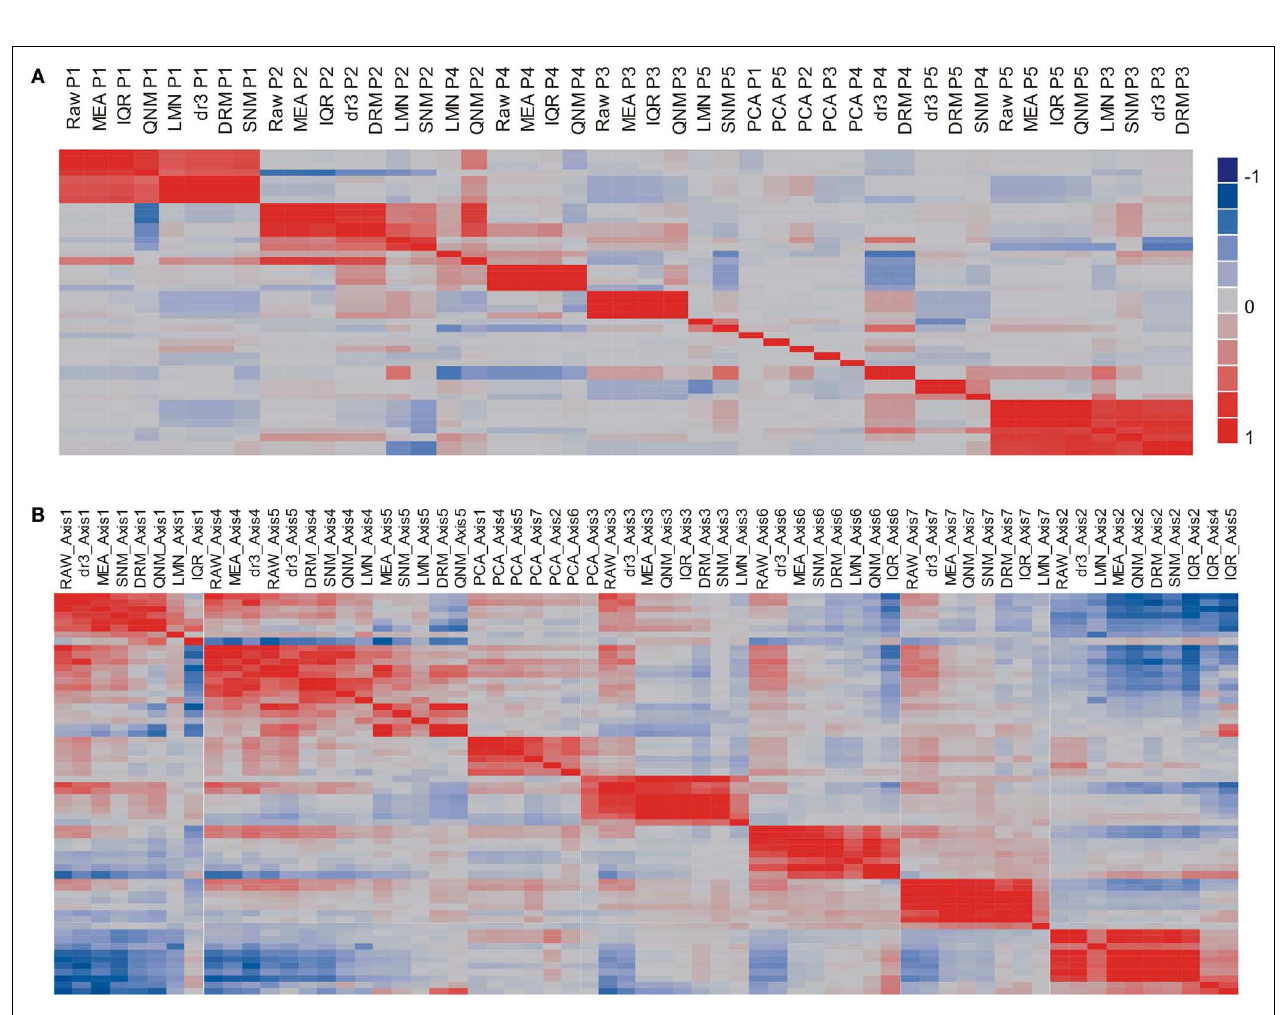
strategies, as is PC2, but that the lower PC fall into different clusters. (B) By contrast, the primary axis of covariance of genes representing seven common axes of immunologically informative variation (Risso et al., 2011) are generally well conserved across all eight normalization strategies (excepting